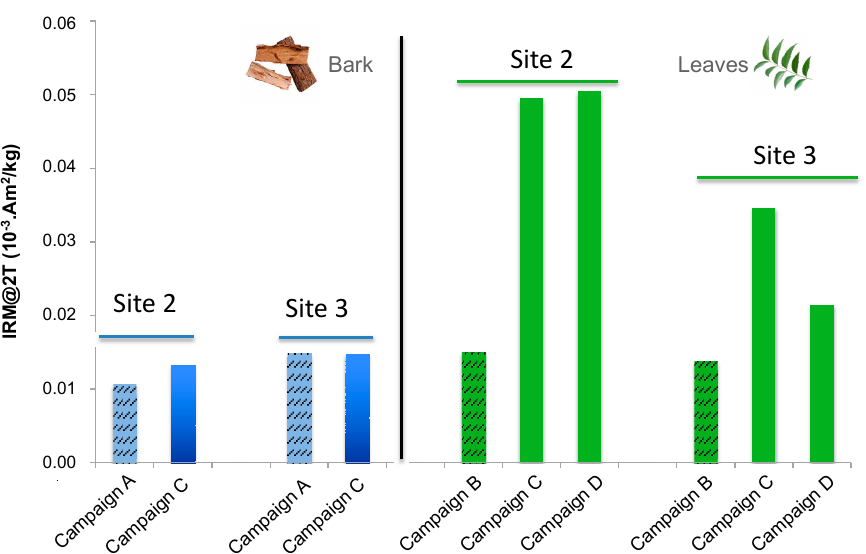
Figure 5. Individual isothermal remanent magnetizations (IRMs) obtained at 2 T for control area site and by campaign. Bark does not present any significant difference between the dry and wet seasons, while leaves display an enhanced magnetic concentration during the dry season compared to the wet season.